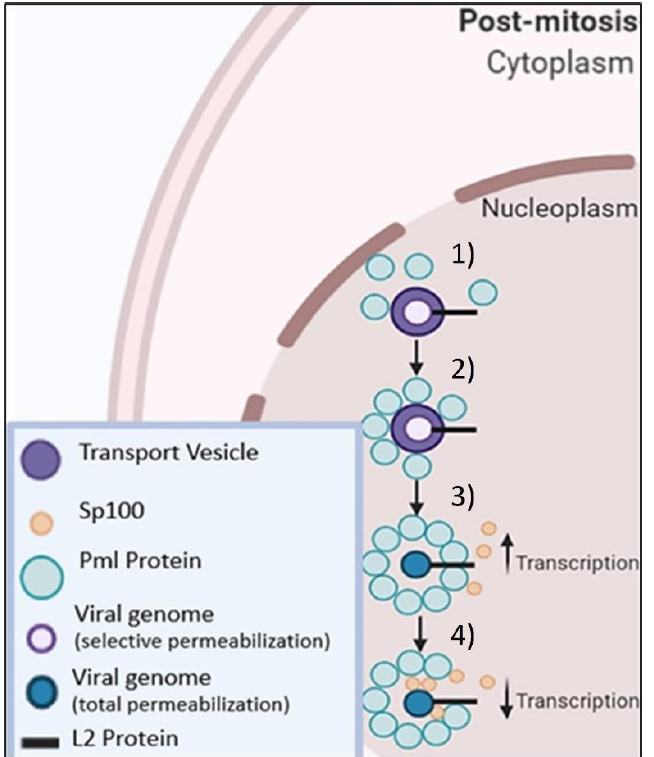
Figure 2. Working Hypothesis of PML & Sp100 Recruitment. ( 1 & 2 ) PML protein(s) are recruited and assembled around the vesicle. ( 3 ) Transcription rates increase with PML proteins surrounding vesicle. ( 4 ) Sp100 is recruited to the vesicles and decreases transcription of viral genome. Adapted from [2] and created with BioRender.